Question: Express in one sentence what the figure is showing.
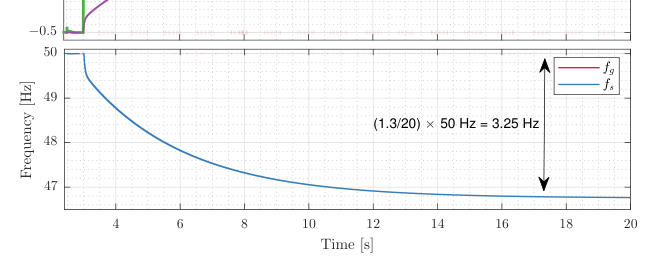
Answer: Main grid disconnection scenario — Top: Active powers in [p.u.] with Sbase; Bottom: ac frequency in [Hz].